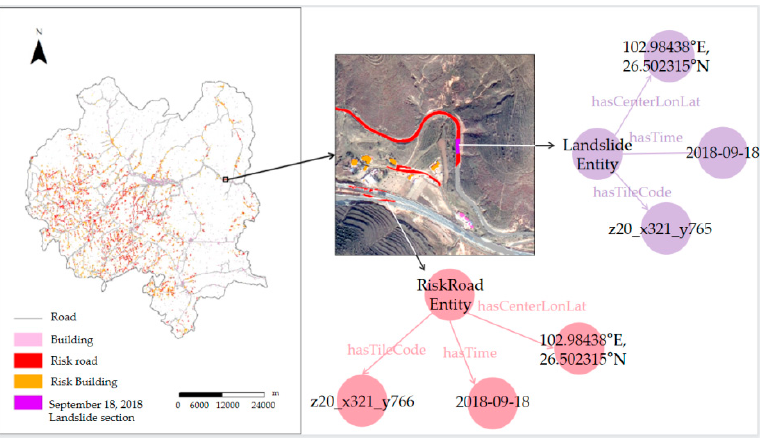
Figure 22. Road distribution map of Xiji County included in the landslide disaster warning area on 18 September 2018. Prediction was carried out in Xiji Country respectively for the area of 3130.00 km 2 , the area of 1509.54 km 2 , and the area of 800.88 km 2 . The experimental results are shown in Figure 23. With the increase of the experimental range, the time of experimental calcula- tion also increases. The performance is basically in a satisfied performance range. There- fore, our method is applicable for large-scale disaster prediction.